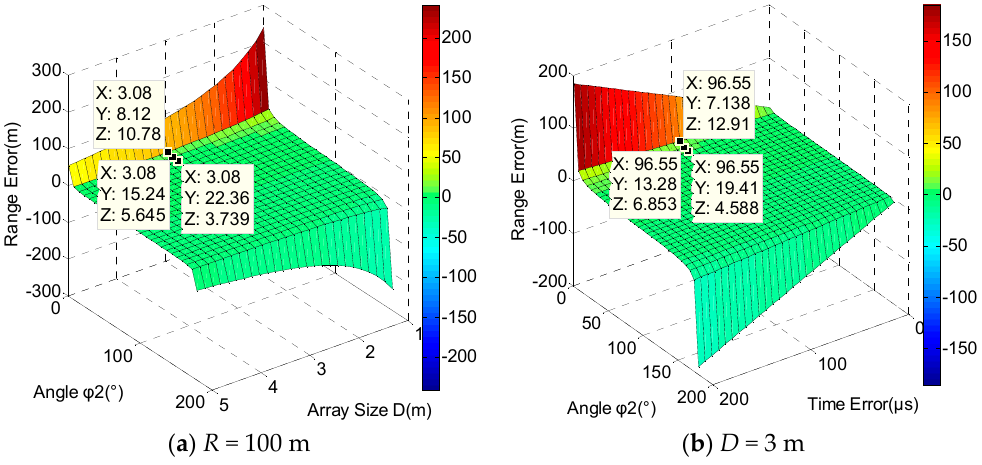
Figure 5. Distributions of the range error of R and D .